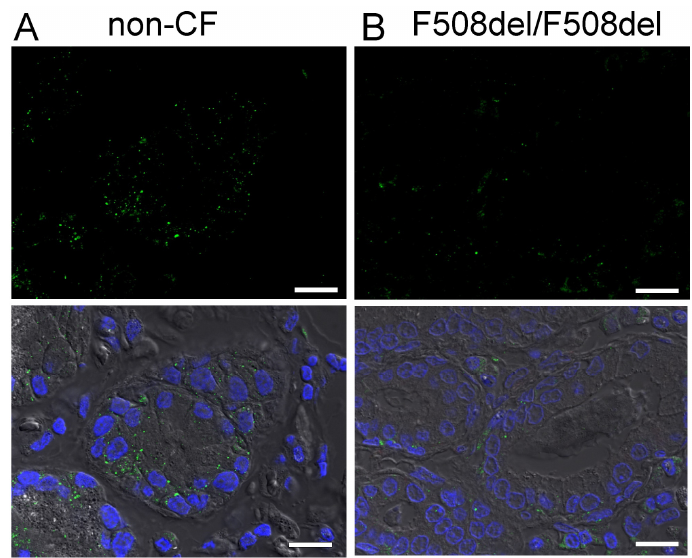
Figure 2. SLC26A9 is not expressed in human airway submucosal glands. Immunohistochemistry of SLC26A9 (green fluorescence) in non-CF ( A ) and CF ( B ) airway submucosal glands. No expression of SLC26A9 is detected in submucosal glands of either non-CF or CF lungs. Bar = 50 µm. Nuclei were stained by DAPI.